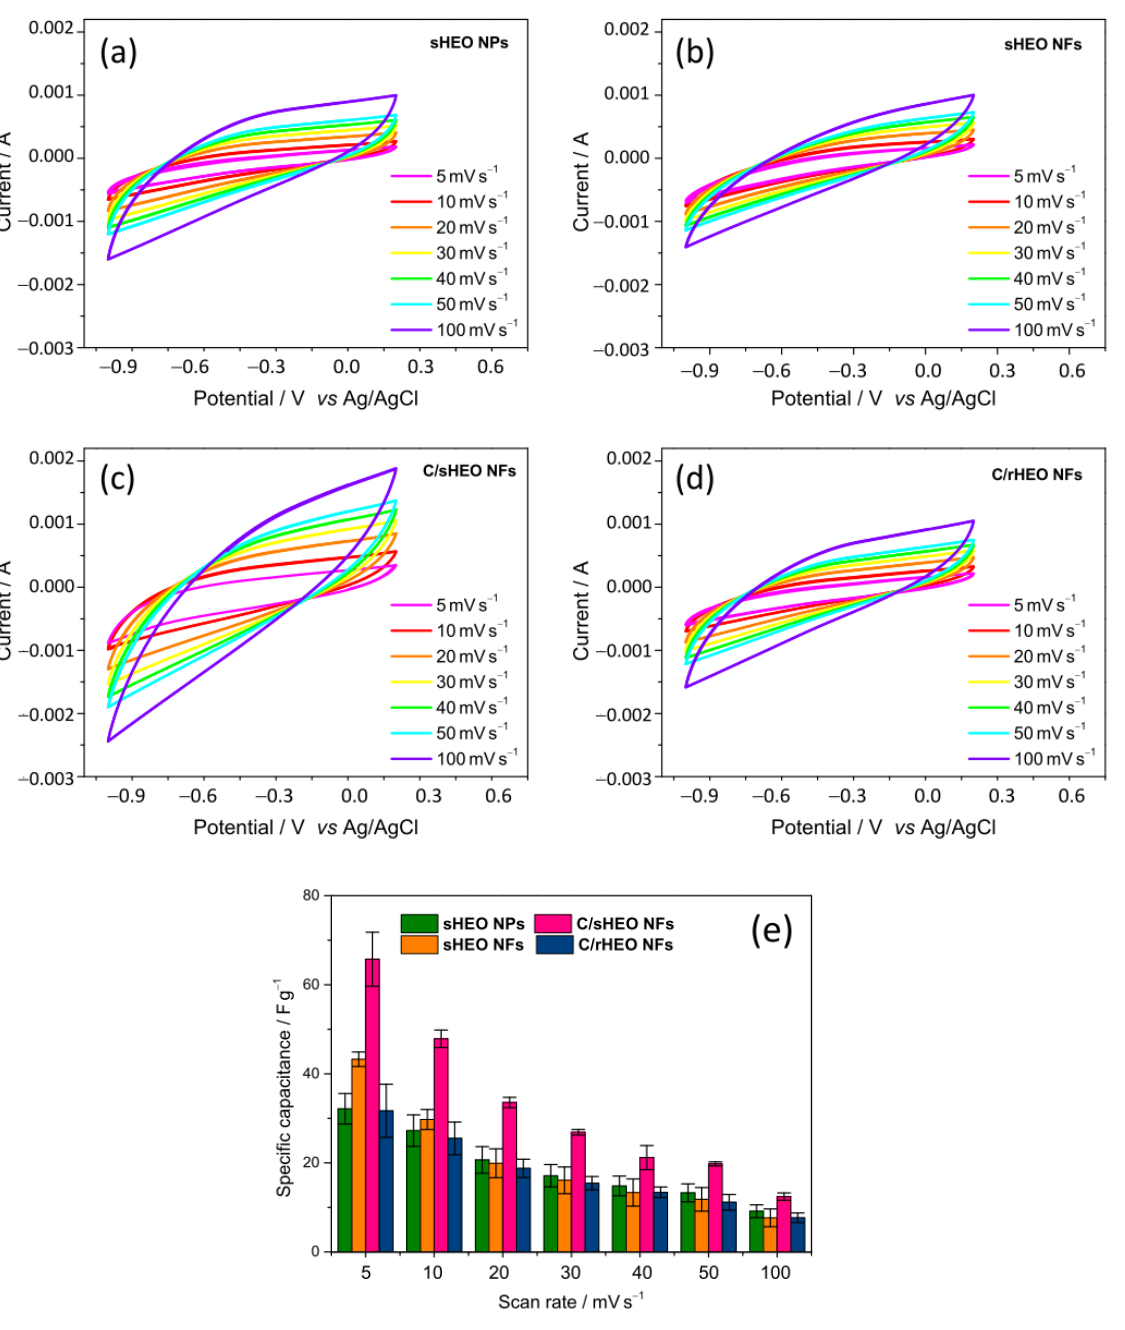
Figure 4. ( a – c ) CV curves of ( a ) sHEO NPs, ( b ) sHEO NFs, ( c ) C/sHEO composite NFs, and ( d ) C/rHEO composite NFs and ( e ) corresponding specific capacitance as a function of potential scan rate.